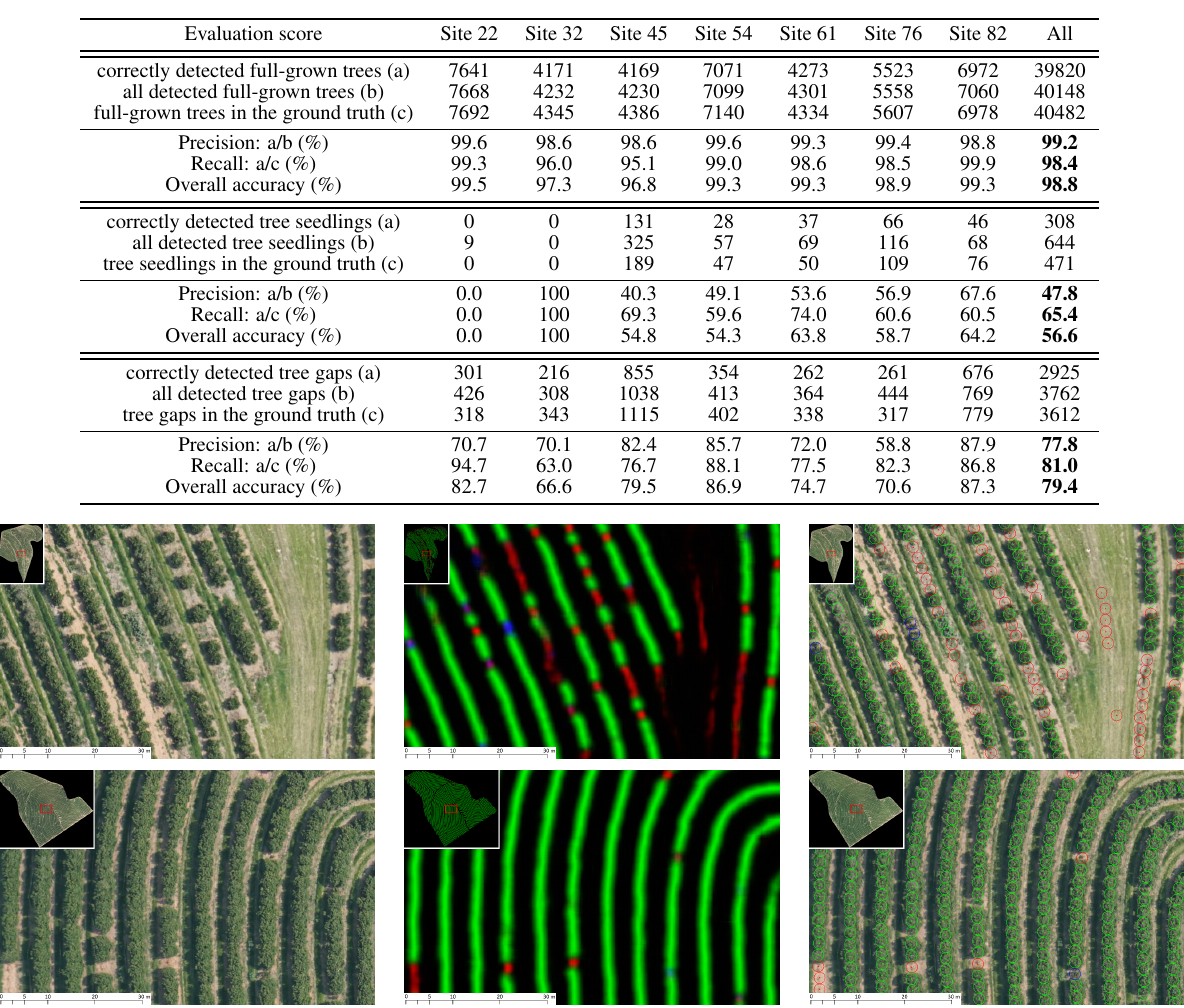
Table 2. Detection results for seven test orchards using the proposed method.